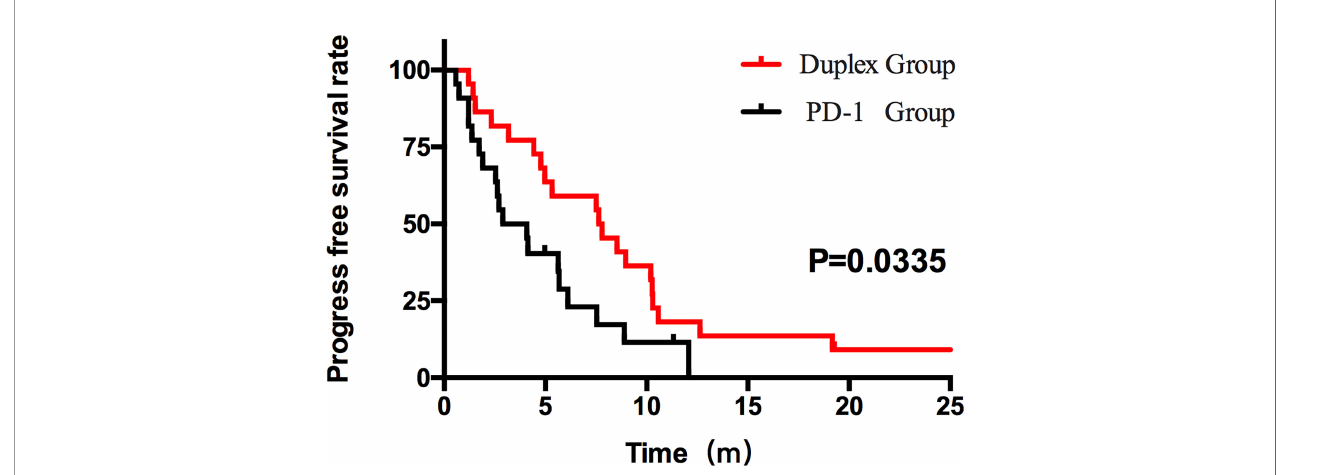
FIGURE 3 | PFS of the duplex group and the PD-1 group. The PFS results between the two groups were statistically signi fi cant (7.63 months vs. 2.90 months, p = 0.0335, HR 0.44, 95% CI [0.236, 0.942]).